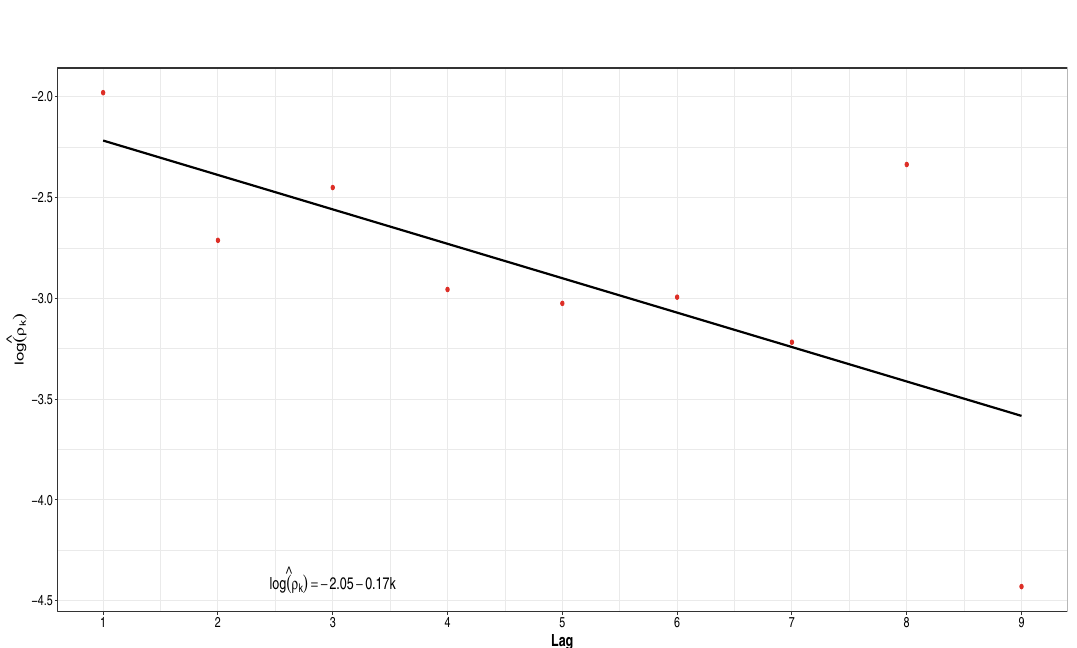
Table 1. Model performance measures (average absolute bias, average interval length and average coverage) summary based on a simulation study.